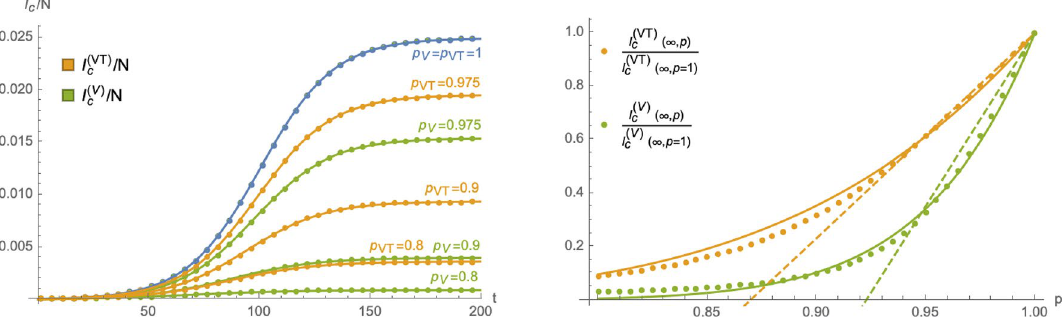
Figure 4. Left panel: cumulative number of infected in the two compartmental HP-models with time dependent parameters (σ 1 , ε) as a function of p VT and p V : orange curves represent the model (4) and green curves the model (6). The blue curve (with p VT = p V = 1 ) is identical in both models (and corresponds to the case of no HP in (1)). Right panel: comparison of the asymptotic cumulative number of infected individuals as a function of p (and normalised to p = 1 ) for (4) and (6). The dots represent the numerical solutions, while the dashed lines stand for the leading (linear) approximation at p = 1 and the solid lines for interpolations with exponential functions of the form (14). The plot uses σ 1 = σ 2 = 1.6 , ε = 0.1 , ζ = 0.15 , ρ = 0.0005 and V 0 = 0.3 and leads to the interpolation parameters θ ( VT ) = 9.326 and θ ( V ) = 20.364 .